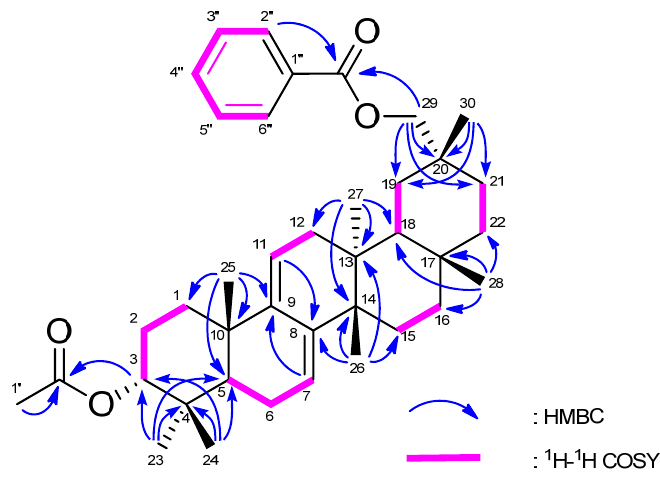
Figure 4. Selected 1 H- 1 H COSY and HMBC correlations for